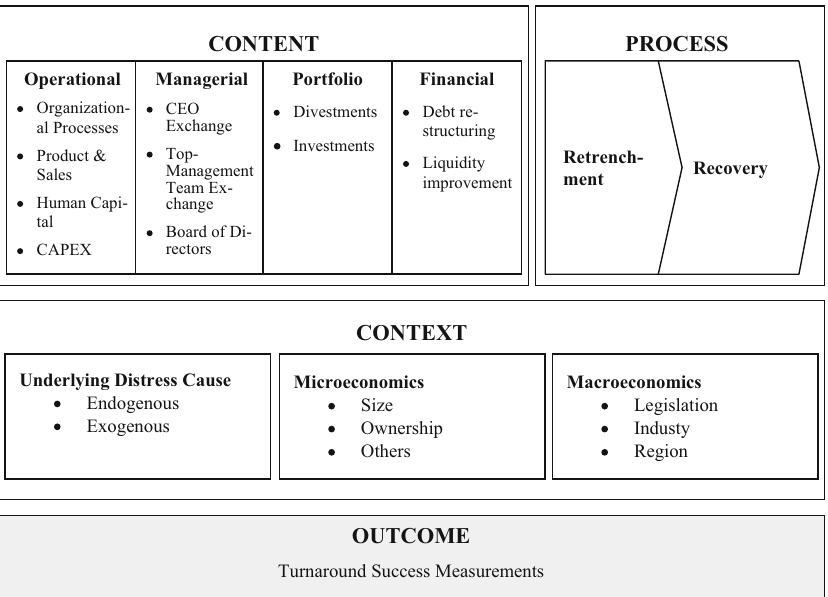
Fig. 3 Turnaround under corporate distress—research